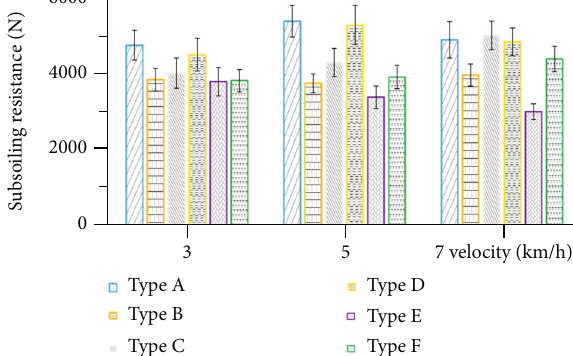
Figure 15: Mean values of subsoiling resistance for six types of subsoilers at three speeds and 20cm